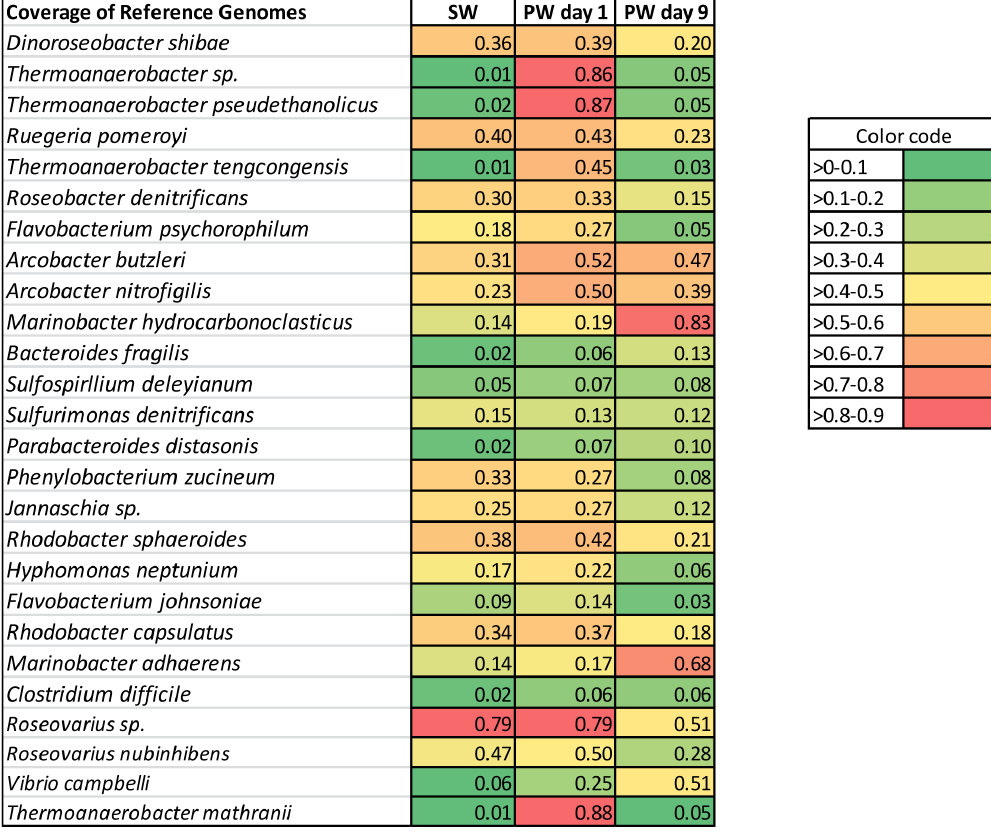
Figure 3. Fraction of genome coverage for source water (SW), produced water day 1 (PW day 1) and produced water day 9 (PW day 9) samples. Reads were mapped against reference genomes using CLC Genomic workbench version 6.5.1 using default parameters. Shown are fractions of reads mapped against each reference genome included in the analysis for all three samples.